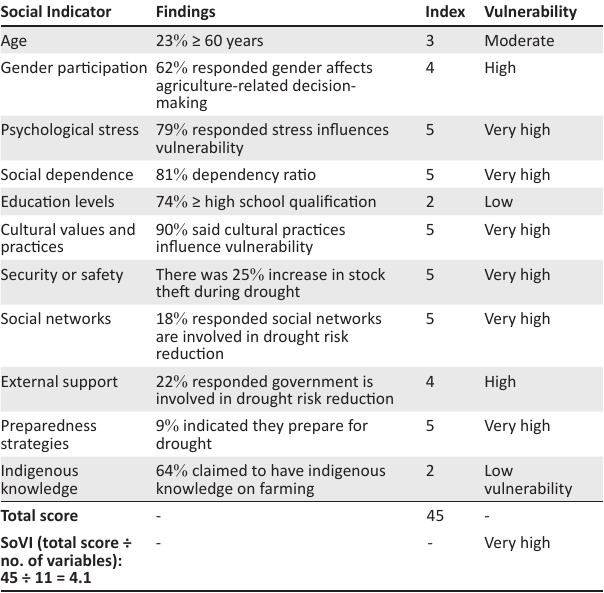
TABLE 2: Estimation of social vulnerability index to drought in O.R. Tambo district. Social